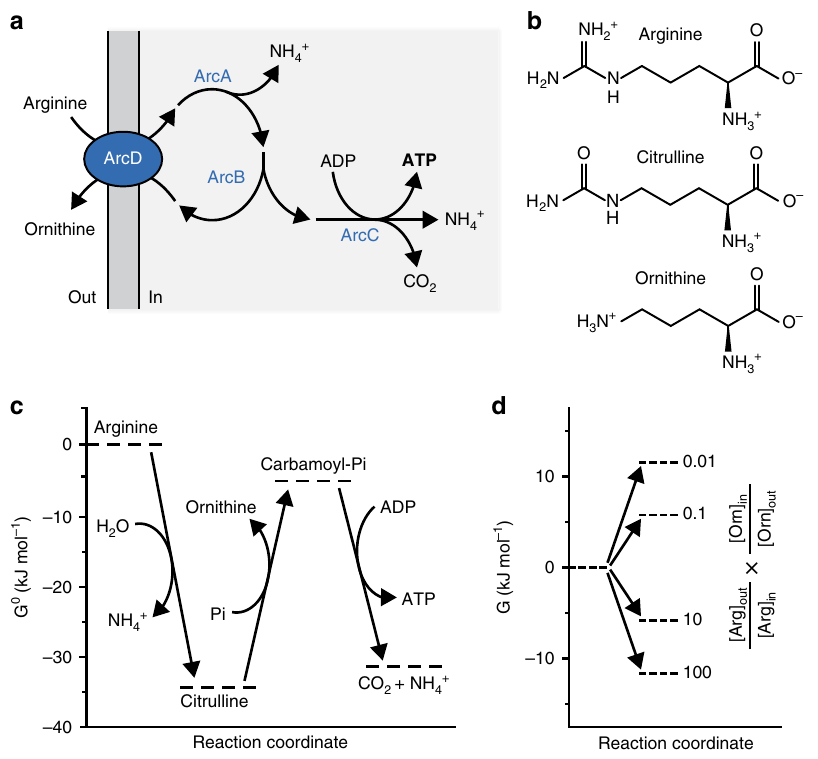
Fig. 1 Layout and thermodynamics of the system. a Schematic representation of the arginine breakdown pathway. b Structures of arginine, citrulline and ornithine at neutral pH. c Thermodynamics of arginine conversion for the reactions of ArcA, ArcB, and ArcC1. G 0 values were calculated for pH 7.0 and an ionic strength of 0.1 M using eQuilibrator 2.2. d Thermodynamics of the arginine/ornithine antiport reaction. G values were calculated at varying concentration gradients of arginine (outside to inside) and ornithine (inside to outside). When the arginine and ornithine gradients are opposite, that is, [Arg] in < [Arg] out and [Orn] in > [Orn] out , then a negative (and thus favorable) G value is obtained. Four scenarios for the product of the arginine and ornithine gradients are